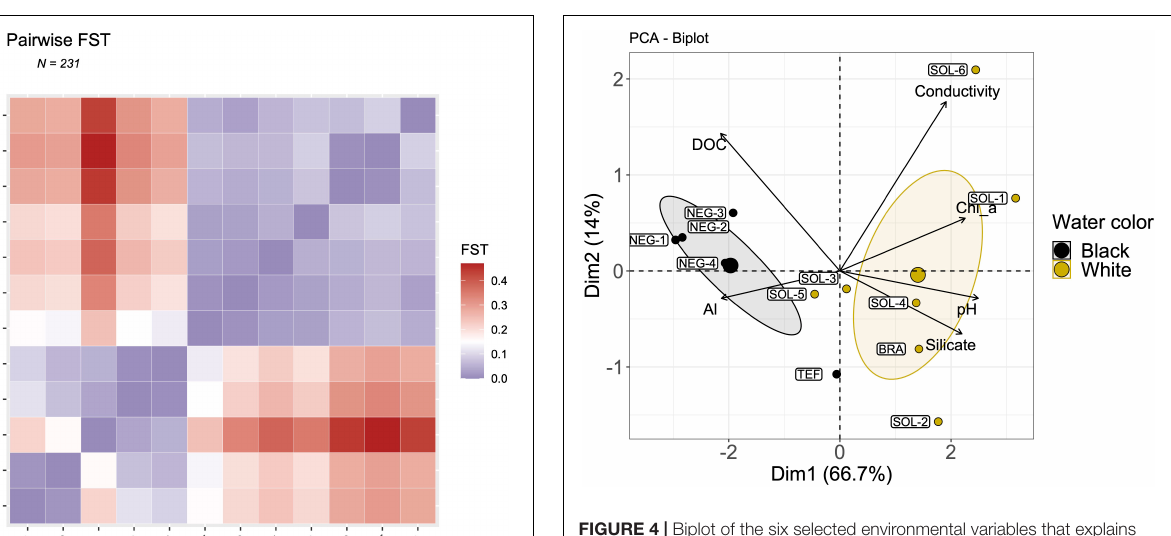
FIGURE 4 | Biplot of the six selected environmental variables that explains most of the differences between the three water types sampled at the 12 sites of the study. Colored ellipses represent a 95% confidence interval for the two water types, with the larger circles representing the centroids (mean values) of each ellipse. The labels identify each site sampled ( n = 12). Vectors length represents each variable contribution to the